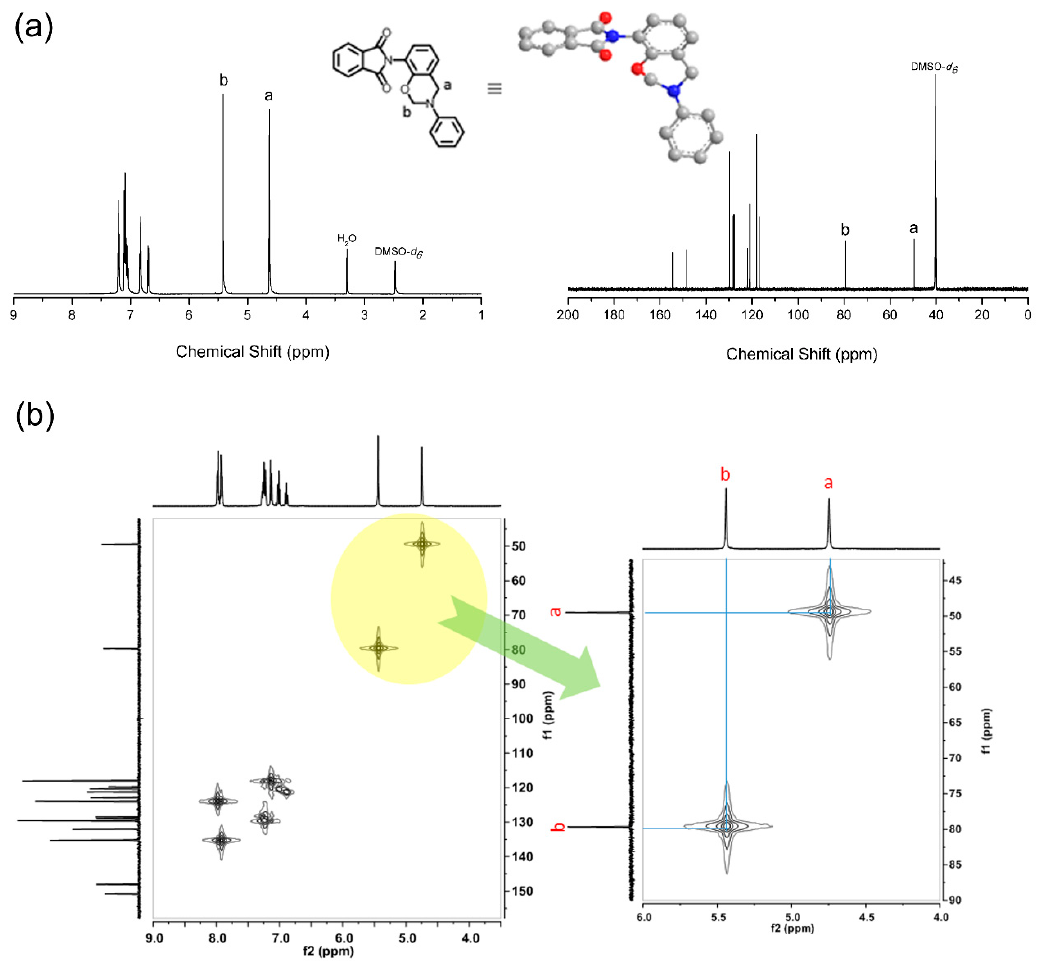
Figure 4. ( a ) 1 H and 13 C NMR spectra of o PP-a. The inset is the DFT-optimized structure of o PP-a. ( b ) HMQC NMR spectra of o PP-a in DMSO- d 6 . The expanded view shows that the oxazine protons of o PP-a are correlated to two different carbon resonances.